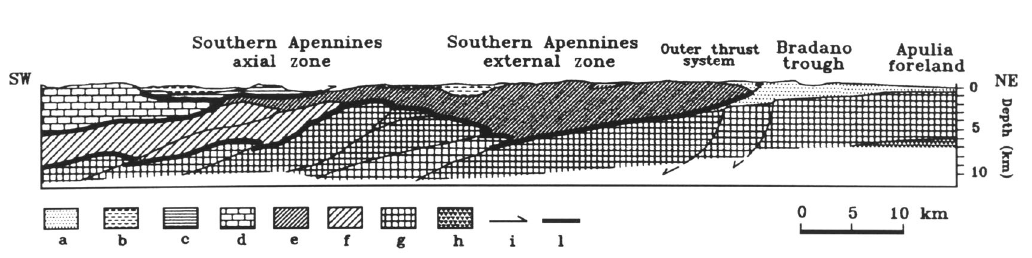
Fig. 7. Schematic section of the shallow structure of the Southern Apennines across the Irpinia region: a – Plio- Pleistocene deposits of the Bradano trough; b – thrust sheet-top succession (Upper Miocene-Early Pleistocene); c – Sicilide and Sannio nappes (Paleogene-Lower Miocene); d – Western Carbonate platform (Mesozoic-Pale- ogene) and Upper Miocene flysh deposits associated with the foredeep phase; e – Lagonegro Basin upper se- quance (Upper Cretaceus-Upper Miocene); f – Lagonegro Basin lower sequance (Lower Triassic-Lower Cre- taceus); g – Apulia Carbonate; h – Verrucano Fm. (Permian Lower Triassic); i – thrusts and normal faults; l – boundary of the main tectono-stratigraphic units (Improta et al. ,